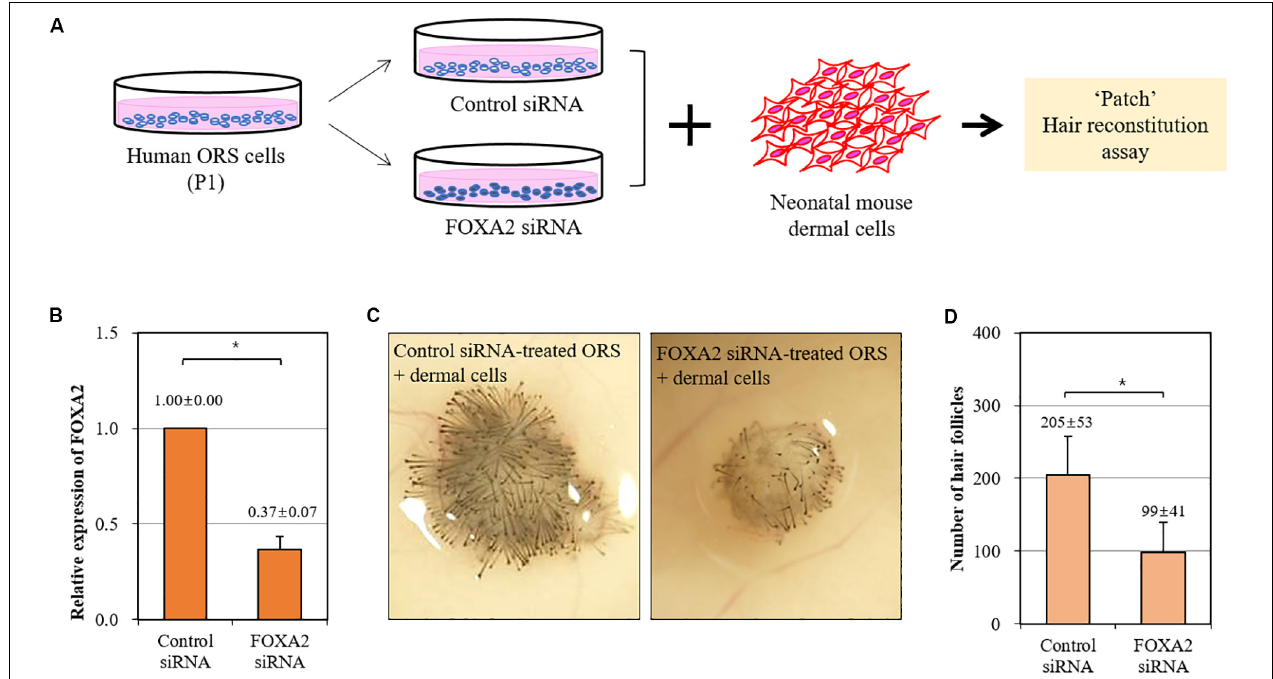
FIGURE 4 | Impairment of hair-inductive activity of ORS cells by knockdown of FOXA2. (A) A schematic illustration of the experimental procedure. (B) The relative expression of FOXA2 in ORS cells transfected with control siRNA or FOXA2 siRNA was measured by qPCR. (C) Representative pictures of induced hair follicles from nude mice skin are shown. (D) The total number of induced hair follicles was counted at each injection site. Data are expressed as means ± standard deviation of eight determinations using three different ORS cell lines from three male patients (ages 38, 50, and 58 years). * P <